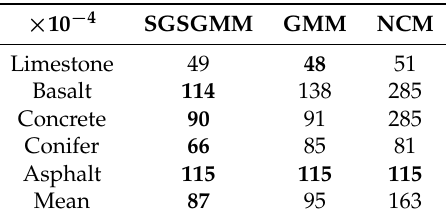
Figure 5. The histograms of the pure pixels for the 5 materials. The x-axis is expressed as a pure pixel for each material via PCA to 1-dimensional space, and the y-axis represents the proportion of occupying each bin size in the histogram. The probability of each distribution is calculated by multiplying the value of the density function at each bin location with the bin size. Table 2. The root-mean-square error (RMSE) calculated between the probability value in each histogram and the estimated value at each bin location for the synthetic dataset. × 10 −